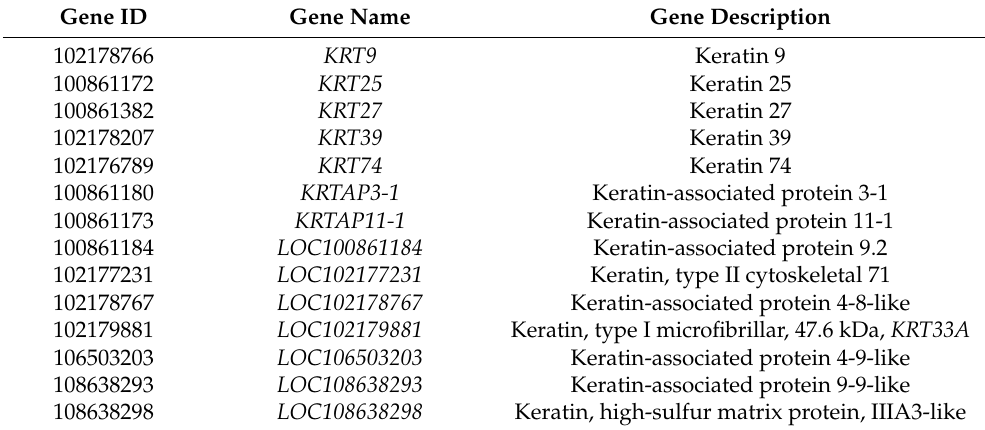
Table 3. Candidate gene information table.